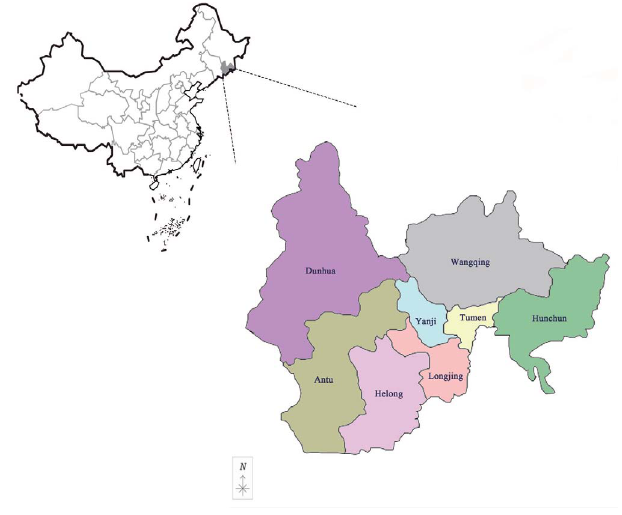
Figure 1. Map of sampling districts in Yanbian, Jilin, China. The different colors represent the various districts sampled in this